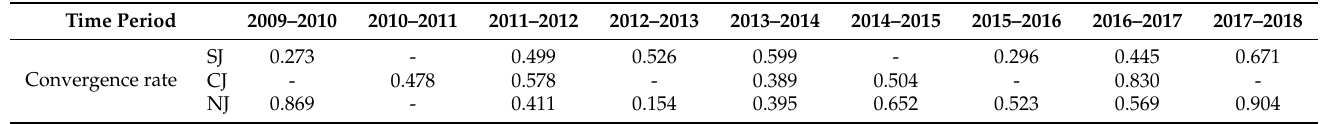
Table 4. Estimation results of club